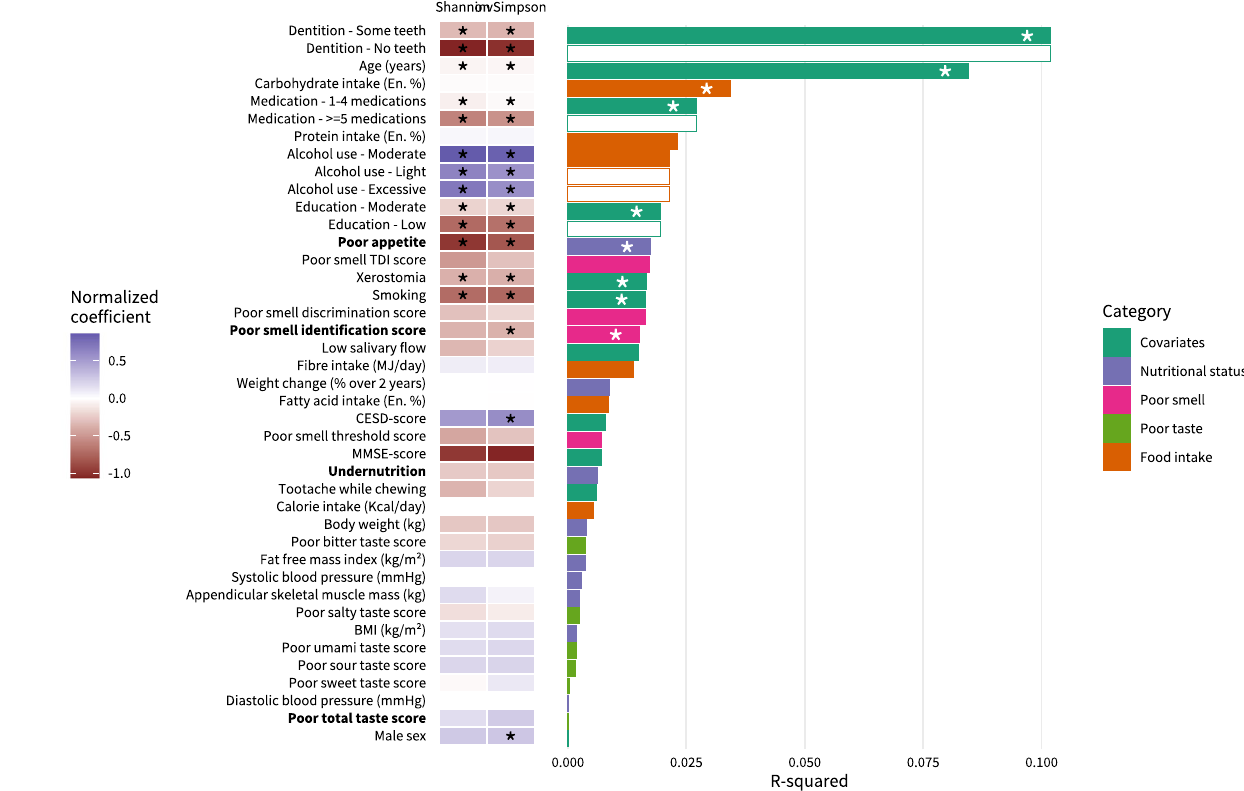
Figure 1. Association of clinical variables with microbiota alpha-diversity and beta-diversity. The heatmap depicts the normalized linear regression coefficients for the associations of clinical variables with Shannon and Inverse Simpson alpha-diversity. Blue indicates a positive association and red a negative association. Bar graphs depict the amount of variance explained by each clinical variable in the Bray–Curtis beta-diversity measure based on PERMANOVA models. Bars are colored based on the type of variable. White bars are shown for values of the same categorical variable. The variables poor appetite, poor smell identification, undernutrition, and poor total taste score concern our main hypotheses and are in written bold text. Asterisks indicate statistical significance at a p value < 0.01. TDI score Threshold discrimination identification score, CESD Centre of epidemiological studies depression scale, MMSE Mini-mental state exam, BMI Body mass